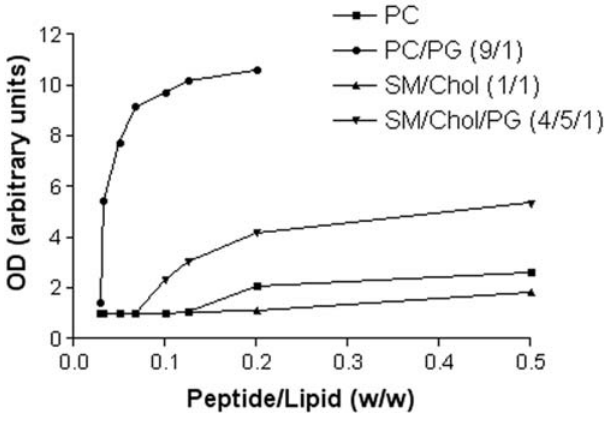
Figure 3. Membrane aggregation by Penetratin. Curves of LUV aggregation as a function of peptide/lipid ratio. LUV aggregation was measured by turbidimetry at plateau (20 minutes after peptide addition). Representative curves of three